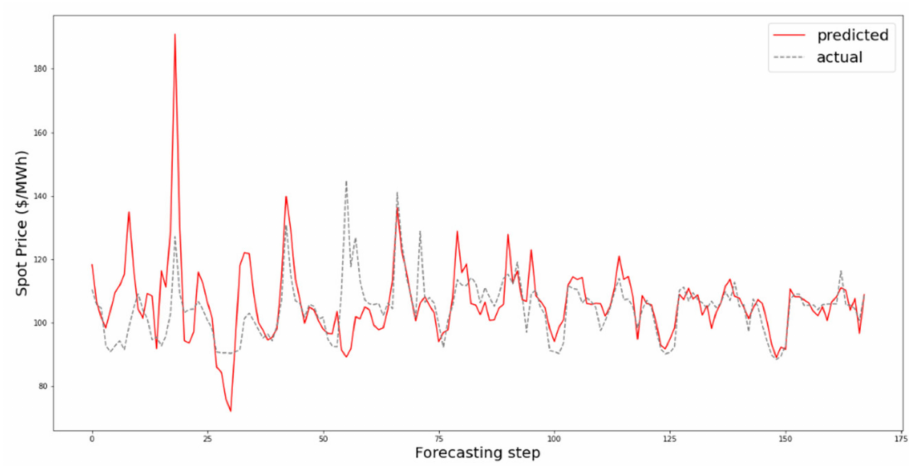
Figure 10. Forecasting performance of RIPPR for 24 h